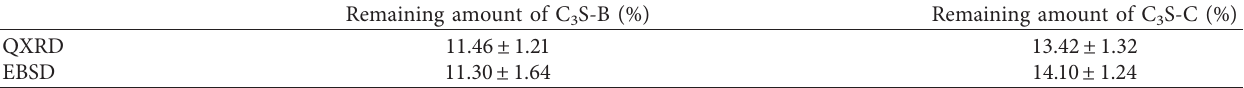
Table 3: Comparison of quantitative results of C